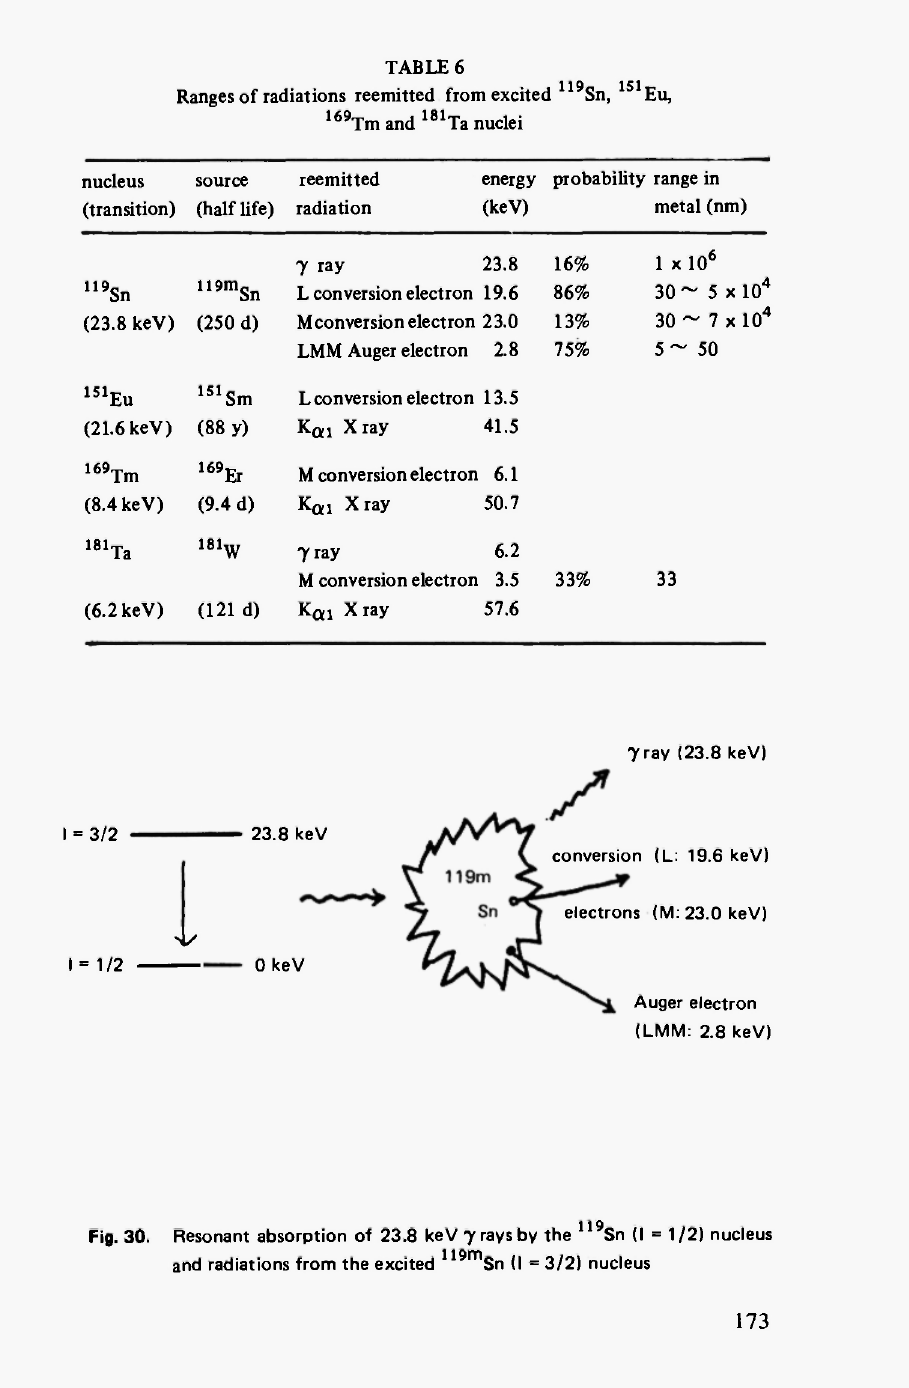
Fig. 30. Resonant absorption of 23.8 keV γ rays by the 119 Sn (I = 1/2) nucleus and radiations from the excited 119m Sn (I = 3/2) nucleus